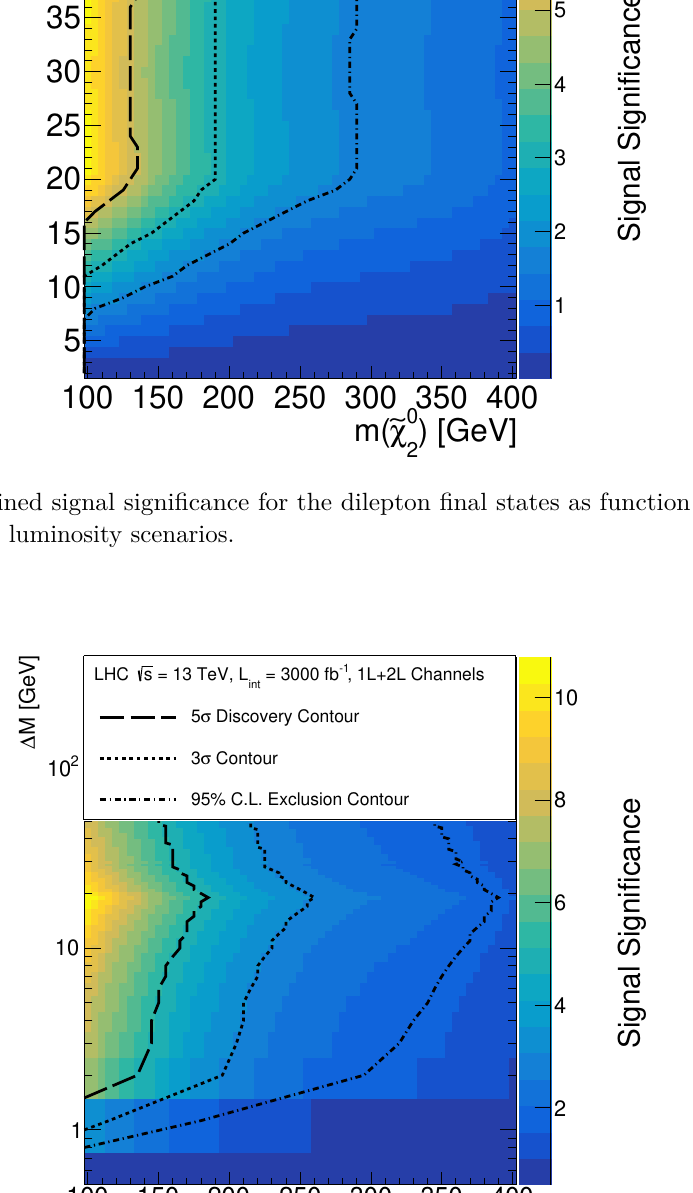
Figure 12 . Total combined signal significance, including the single lepton and dilepton final states as function of ˜ χ 0 mass, for different integrated luminosity 2